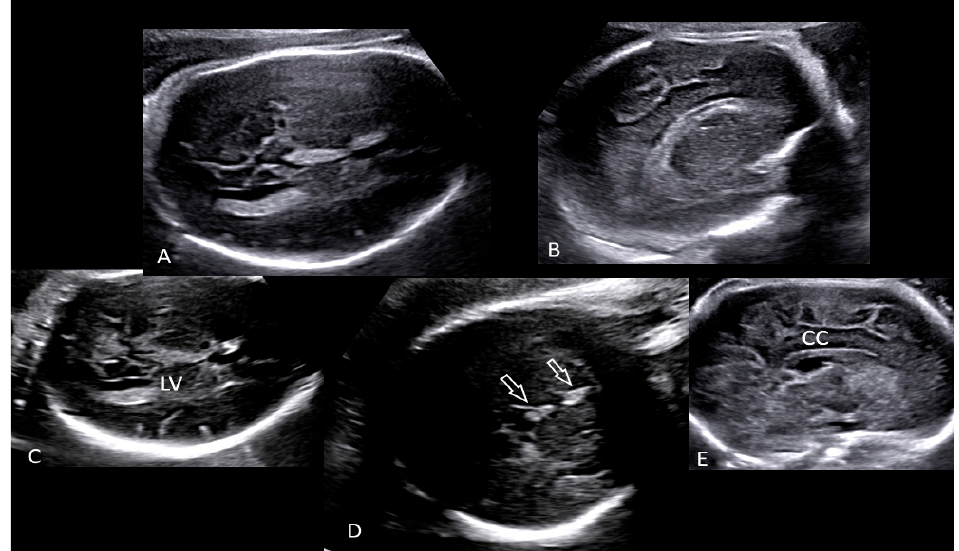
Figure 1. Transabdominal neuroscan ( A – E ) performed in the delivery room detected hyperechogenic- ity ( D , open arrows) involving both choroid plexuses of the lateral ventricles (LV) as well as the falx cerebri . Brain contour was smooth without recognizable gyri and sulci ( A , B , E ). (Legend: CC: corpus callosum; LV: lateral